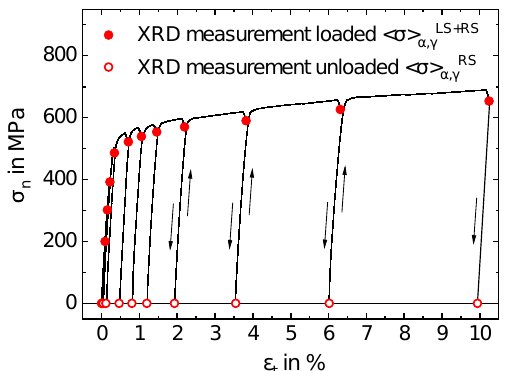
Figure 5. Loading and unloading scheme for XRD analysis of phase-specific stress development (LS = loading stress; RS = residual